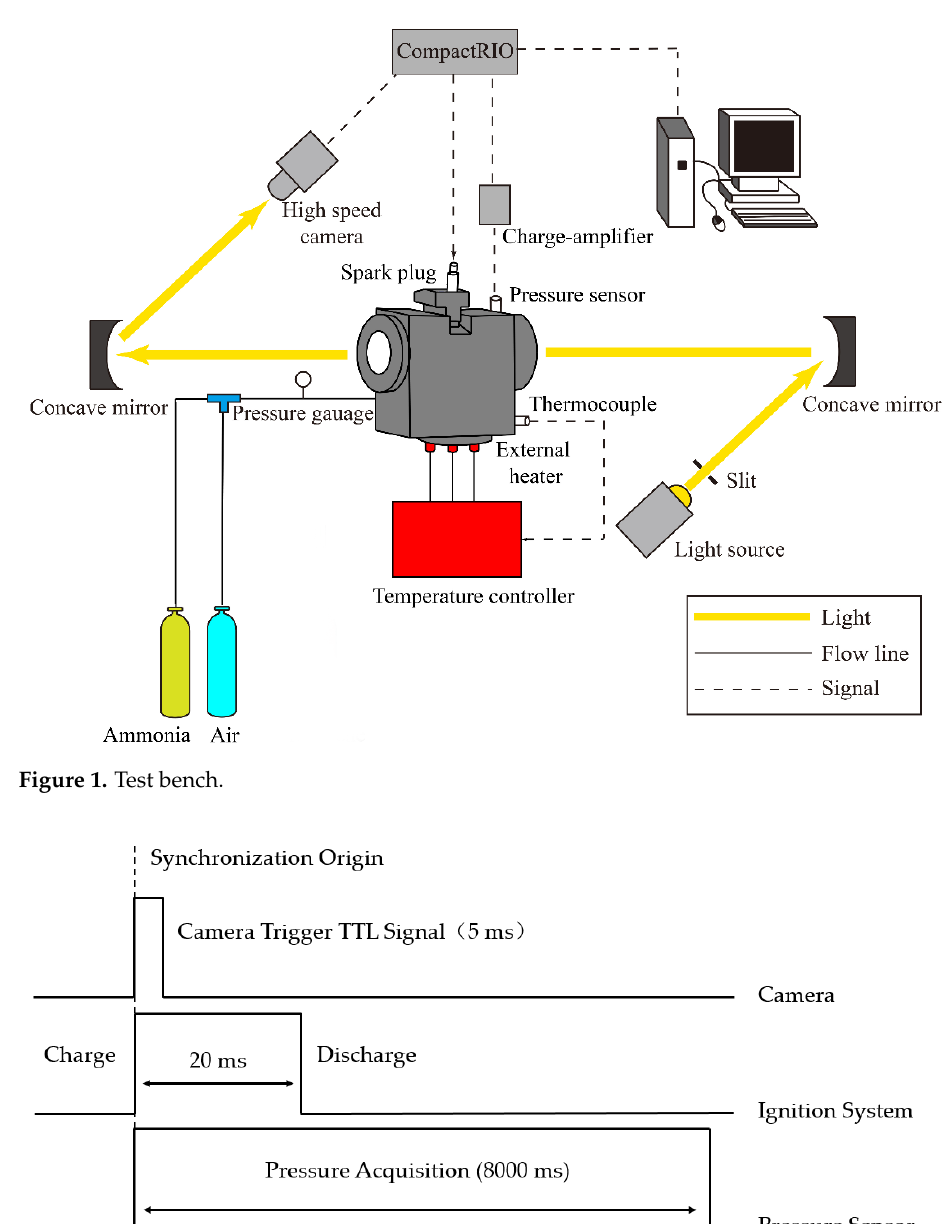
Figure 2. Synchronization signal.